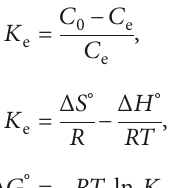
y = –3.472 x + 12.24